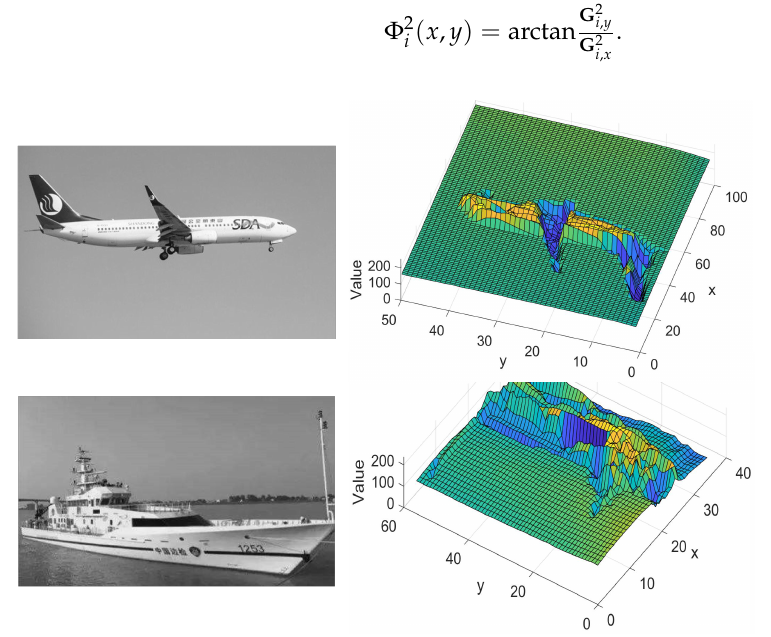
Figure 1. Original images ( left part ) and their surface plots ( right part ).